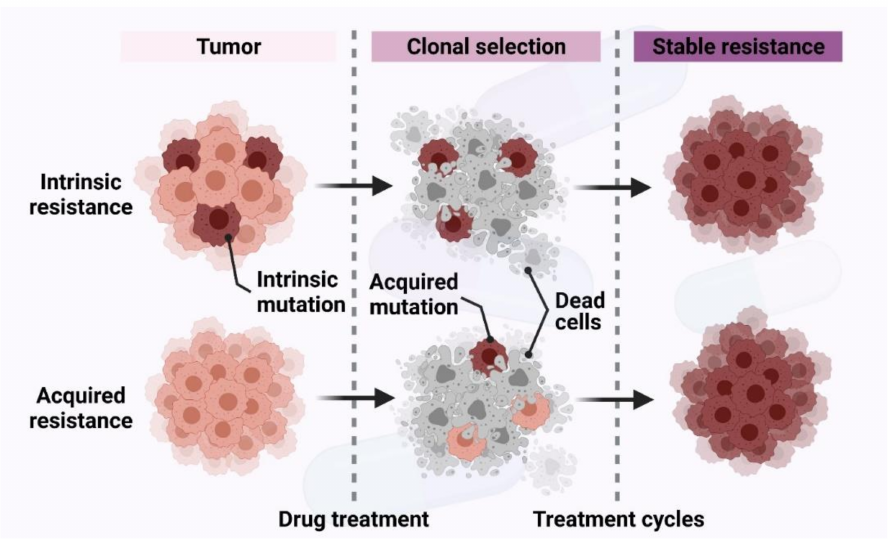
Figure 3. Intrinsic and acquired chemoresistance in